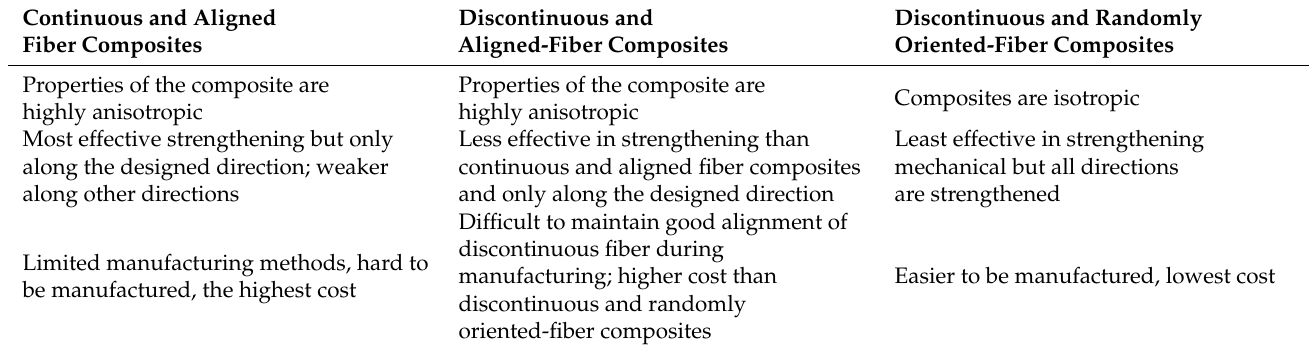
Table 4. Brief comparison of fiber reinforced composites, according to length and orientation of fiber